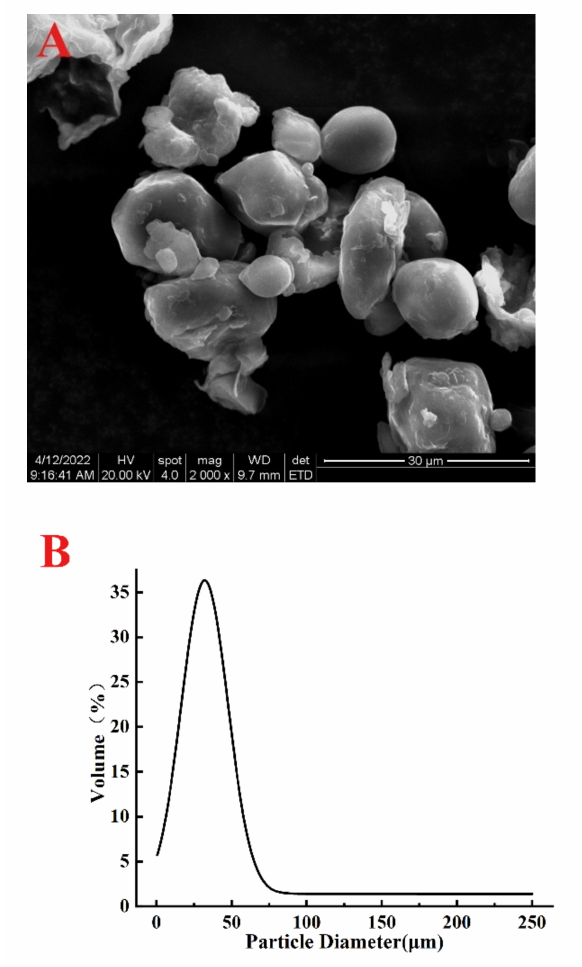
Figure 1. SEM image ( A ) and size distribution ( B ) of sorghum